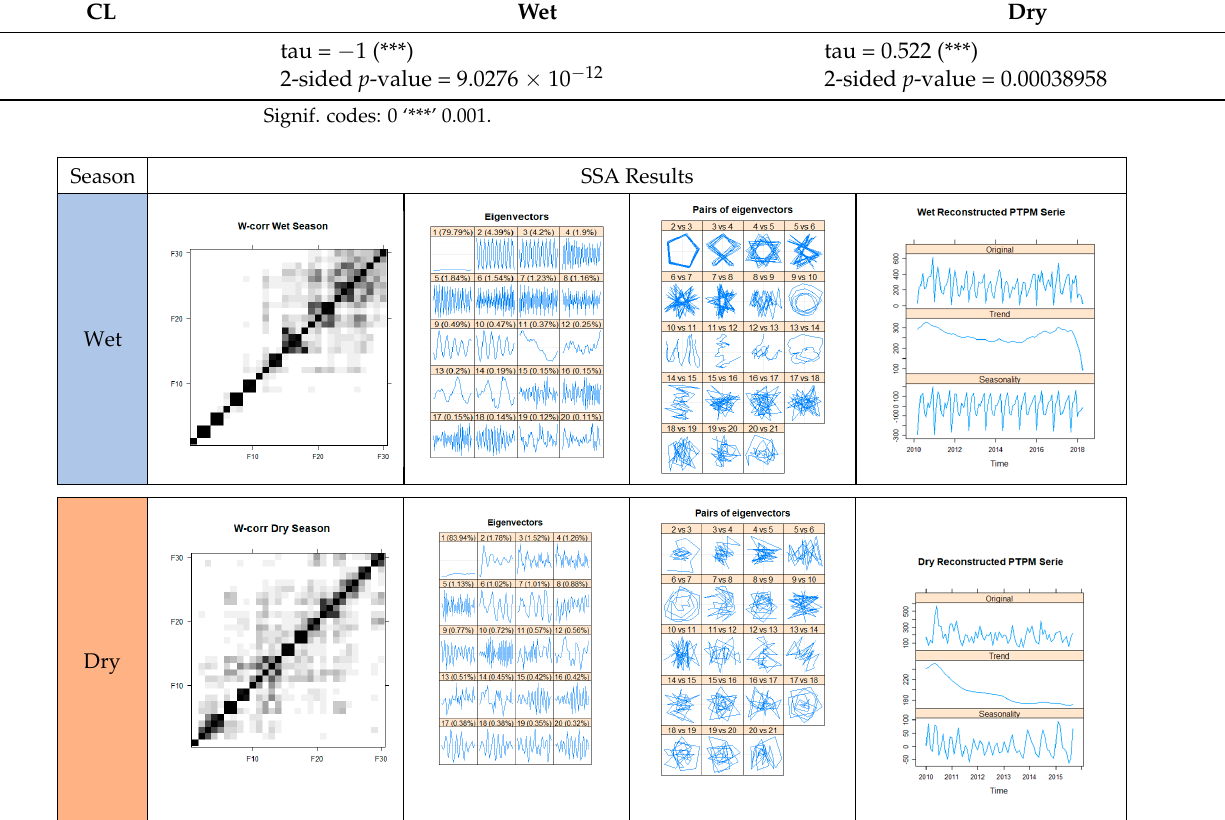
Table A1. Mann–Kendall Results for forecasted tendency components in wet and dry seasons (significance level: α = 0.05).